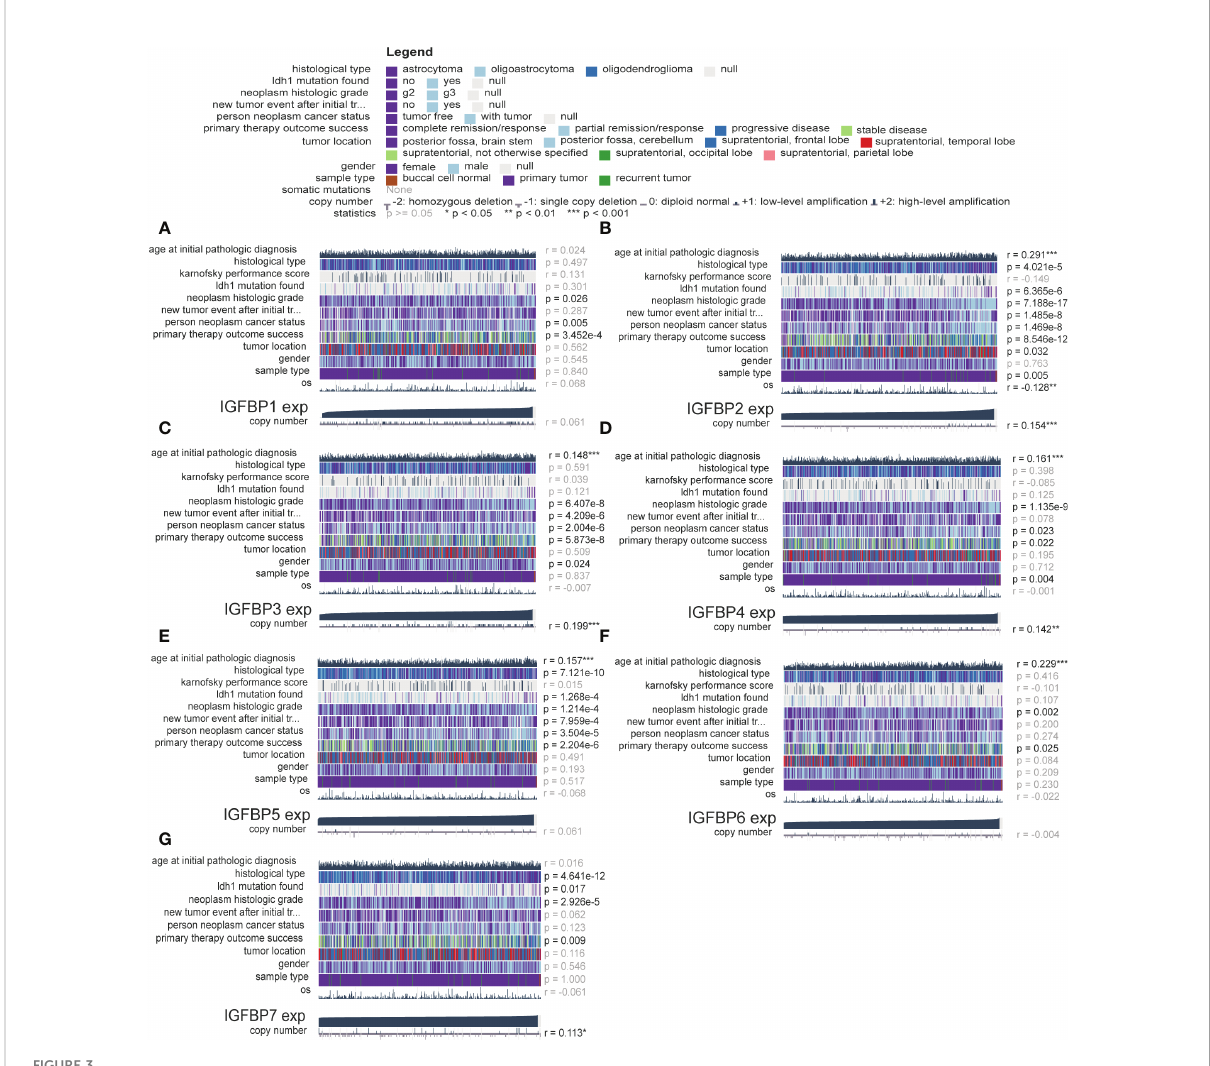
FIGURE 3 Validation of the clinical value of the IGFBP family. (A – G) Correlation heatmap of IGFBP family expression versus clinical traits in the glioma cohort. Each column in the graph represents a sample, while each row represents a variable. OS, overall survival. For all experiments, mean rank, *p<0.05, **p<0.01,